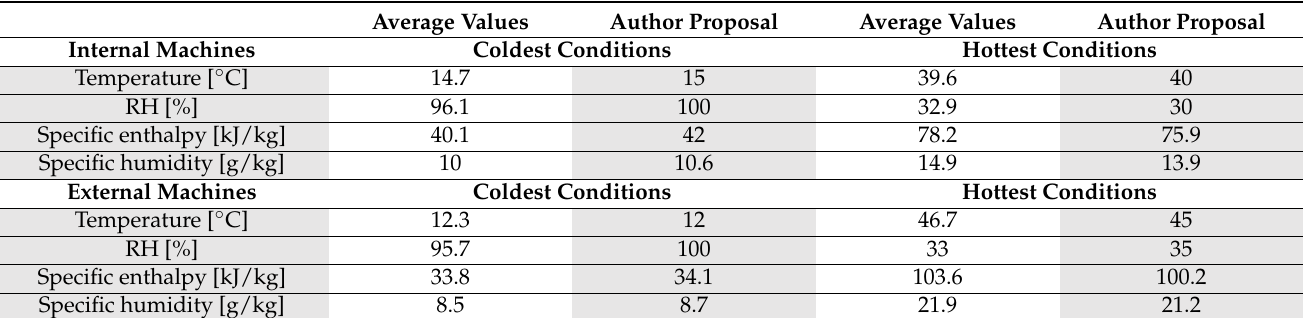
Table 3. Reference conditions for internal and external